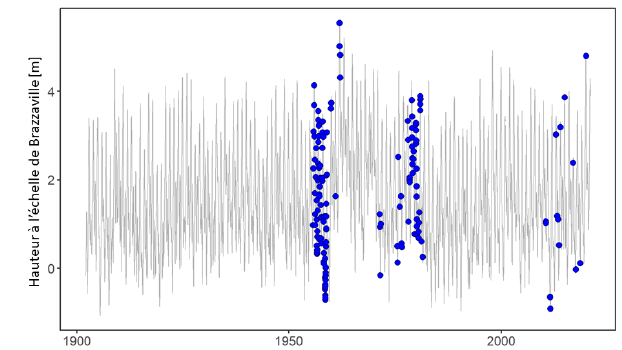
Figure 1. Série de hauteurs d’eau du Congo à l’échelle de Brazza- ville et les jaugeages disponibles (points